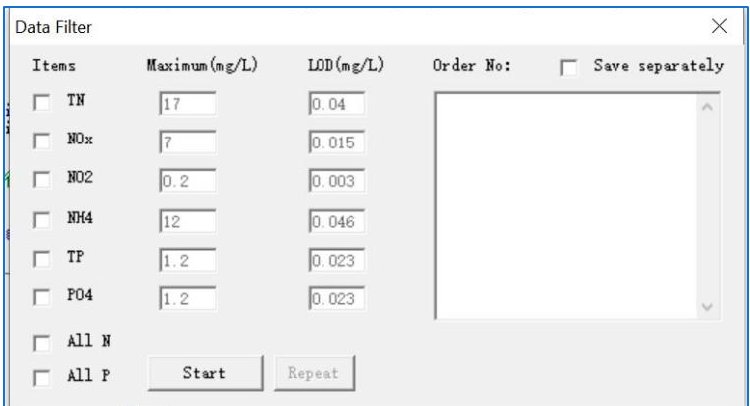
Figure 2. Filtering module interface.